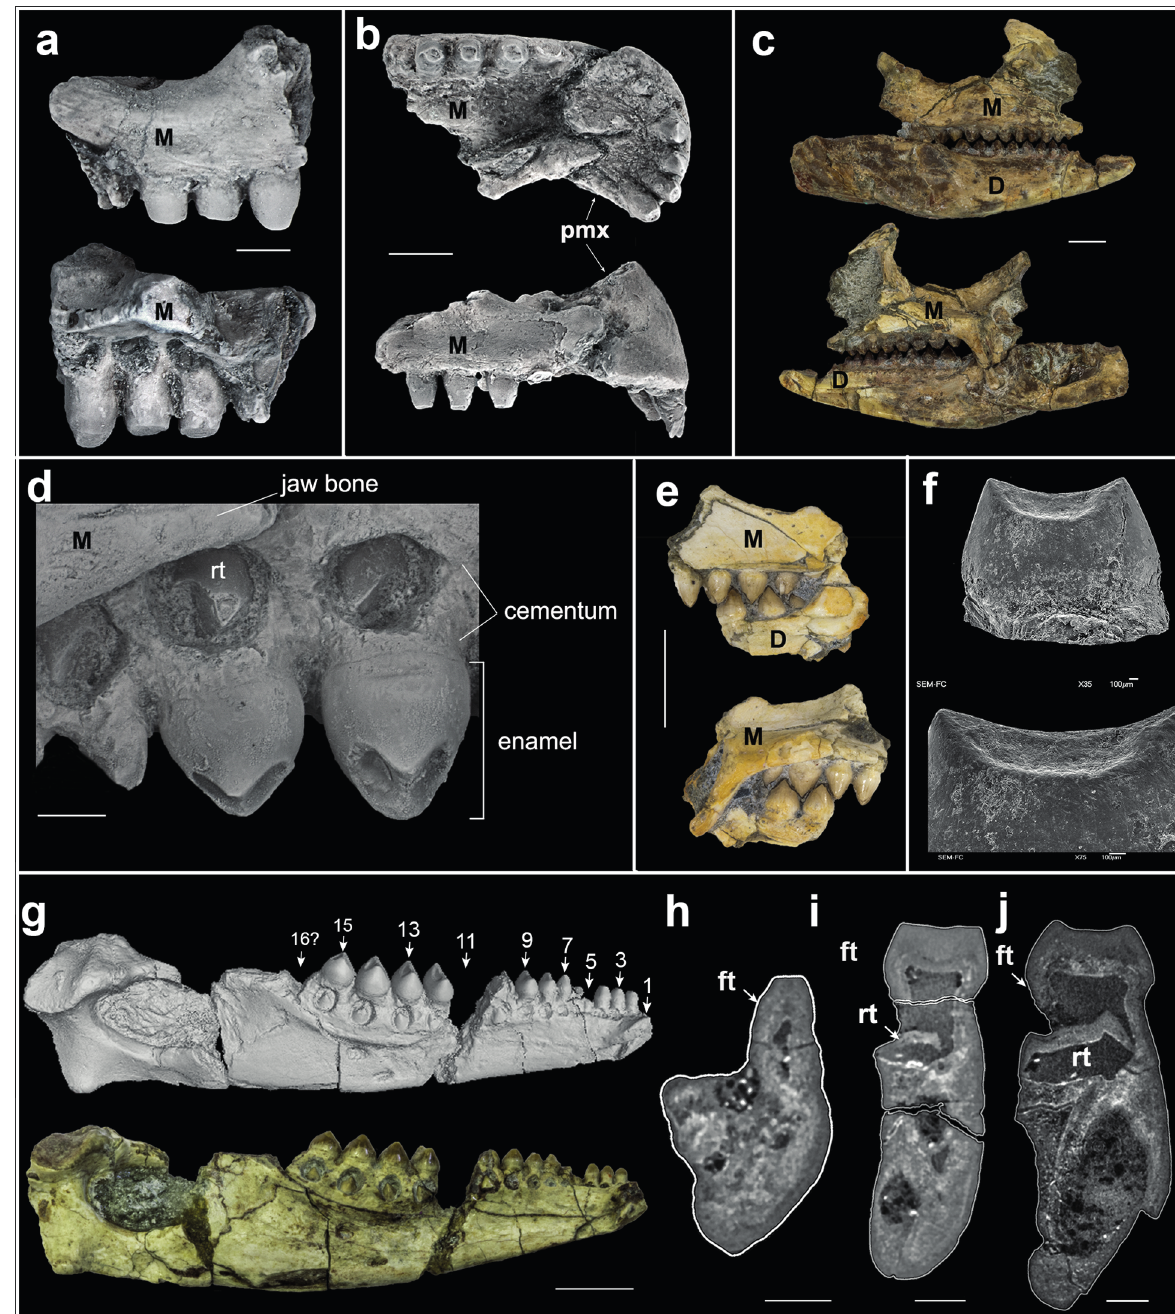
Figure 2 - a , labial and lingual views of the most anterior part of the left maxilla (IGM4979); b , premaxila and the most anterior part of the right upper jaw in occlusal and labial views (IGM4972); c , labial and lingual views of the upper and lower jaw in occlusion (IGM4970); d , close up of the last tooth position (IGM4977); e , labial and lingual views of the most posterior fragments of upper and lower jaws in occlusion (IGM4982); f , mesial view of isolated tooth, with evidence of abrasive surface wear (IGM4984); g , 3D image and photography in lingual view (IGM4975); h , second tooth position, lingual expansion of tooth row to its base; i , ninth tooth position, showing the apicollingual attachment; j , twelfth tooth postion, more apically but with the contribution of its base to the tooth row. D, dentary, M, maxilla, pmx, premaxilla, rt, replacement tooth, ft, functional tooth. Scale bar in a , b , d , h , i and j equals 1mm; in c , e and g equals 5mm, f equals 100